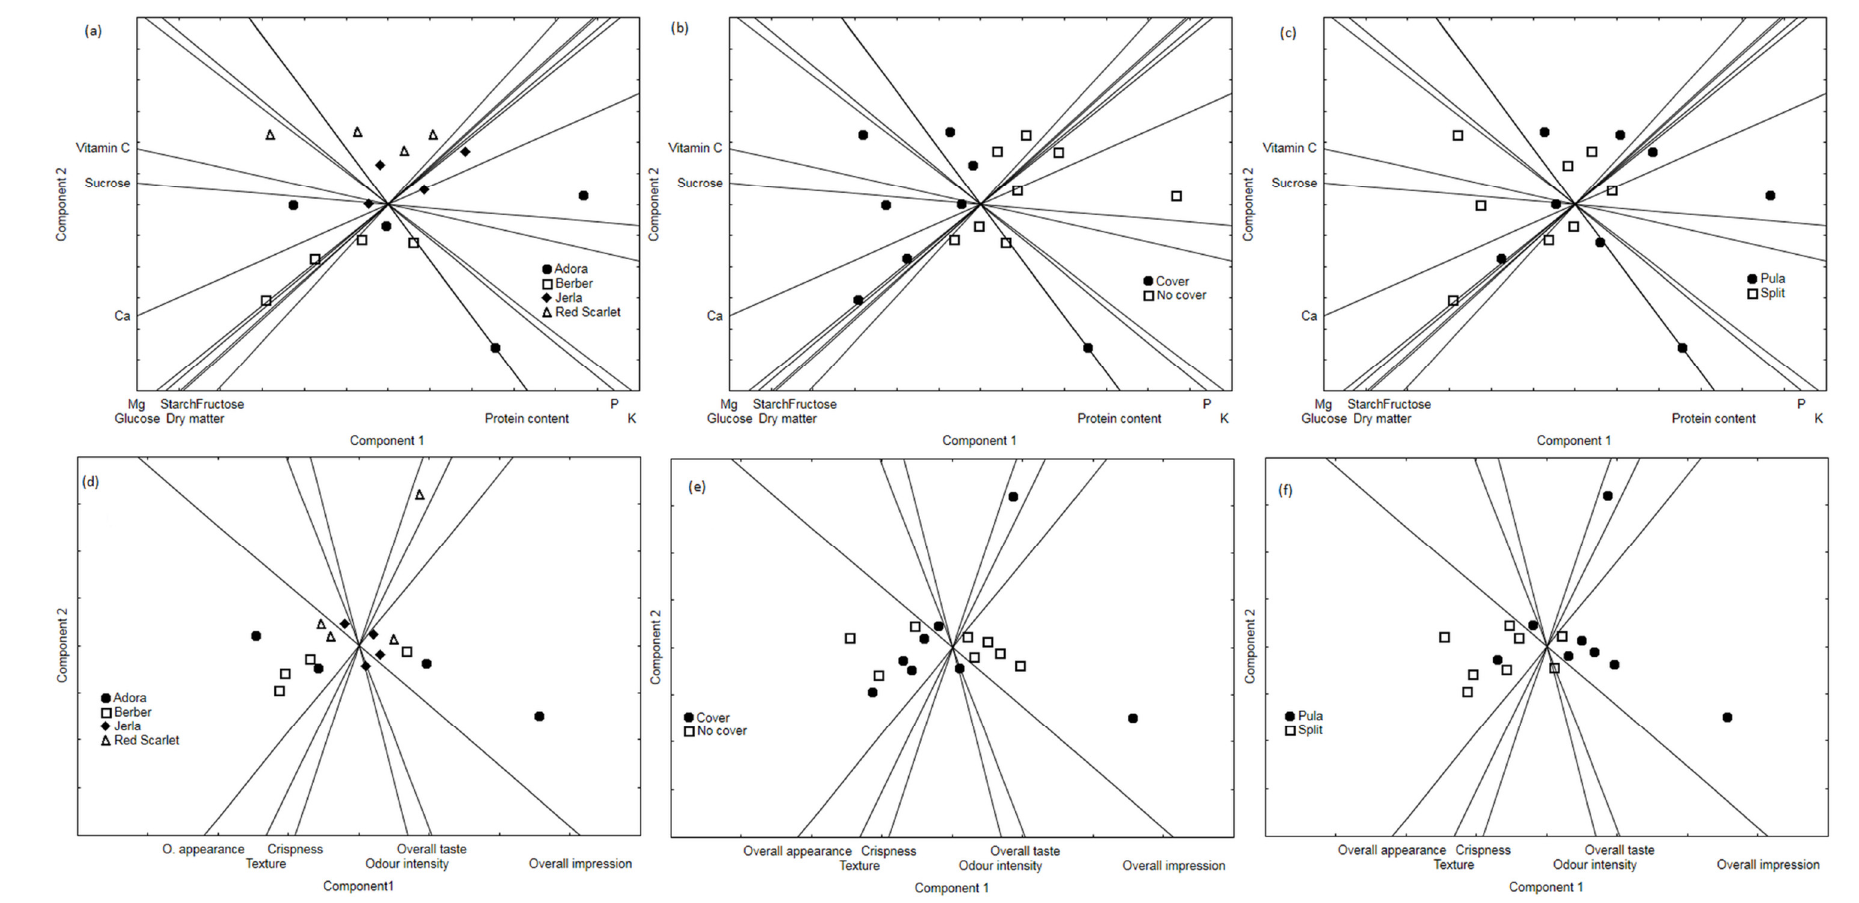
Figure 2. PLS models of the effect of ( a ) cultivar, ( b ) plant cover, ( c ) location on “early” potato physicochemical parameters and the effect of ( d ) cultivar, ( e ) plant cover, ( f ) location on oil-fried “early” potato sensory characteristics in the first harvest year.